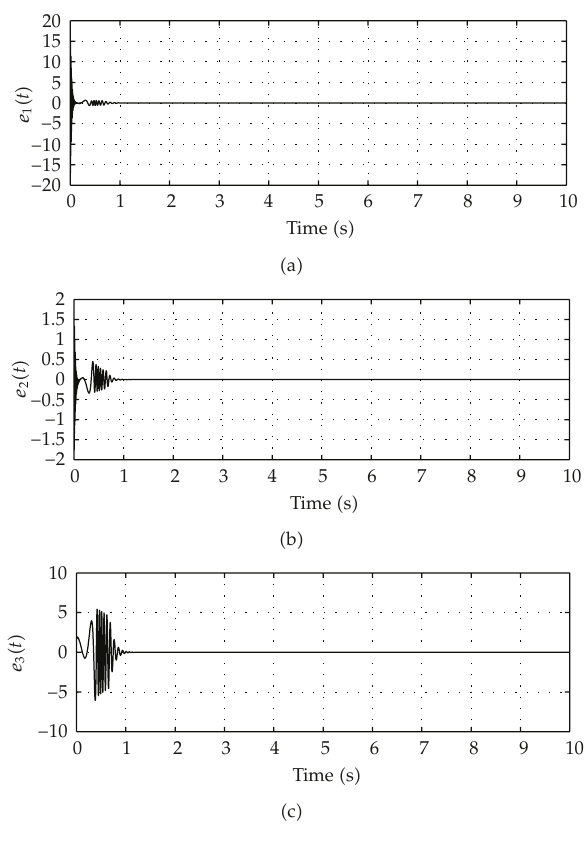
Figure 2: Synchronization errors.